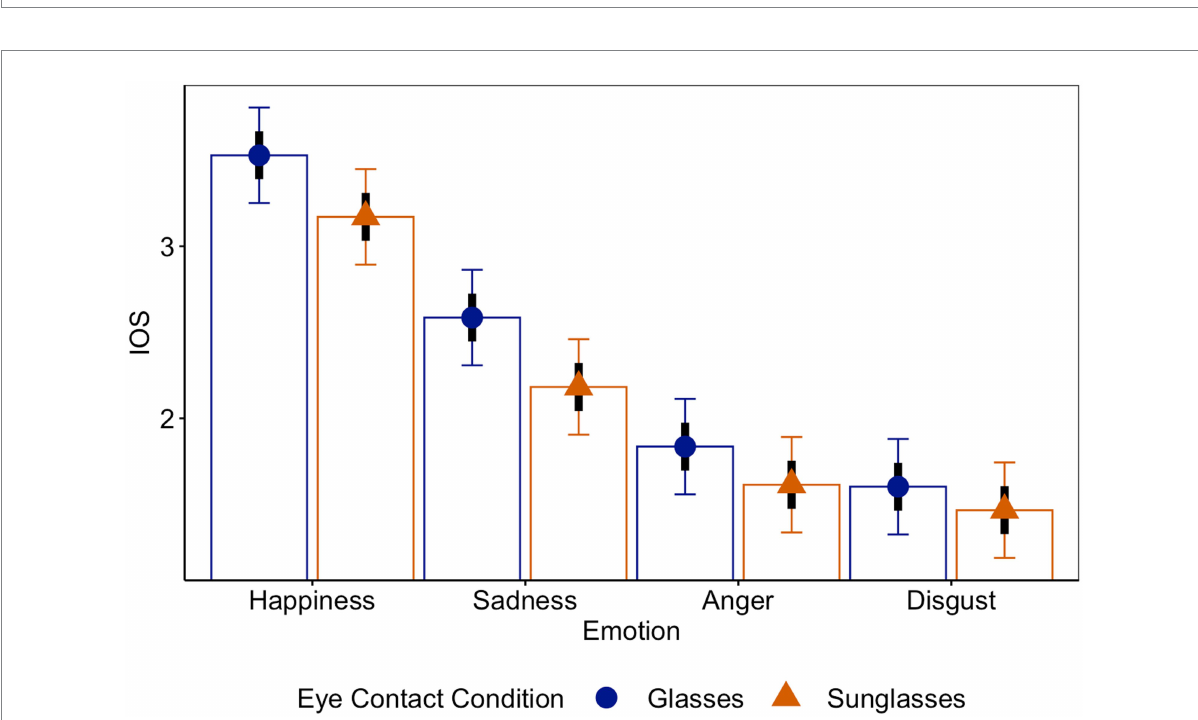
FIGURE 3 Perceived interpersonal closeness (IOS) as a function of eye contact and emotion.